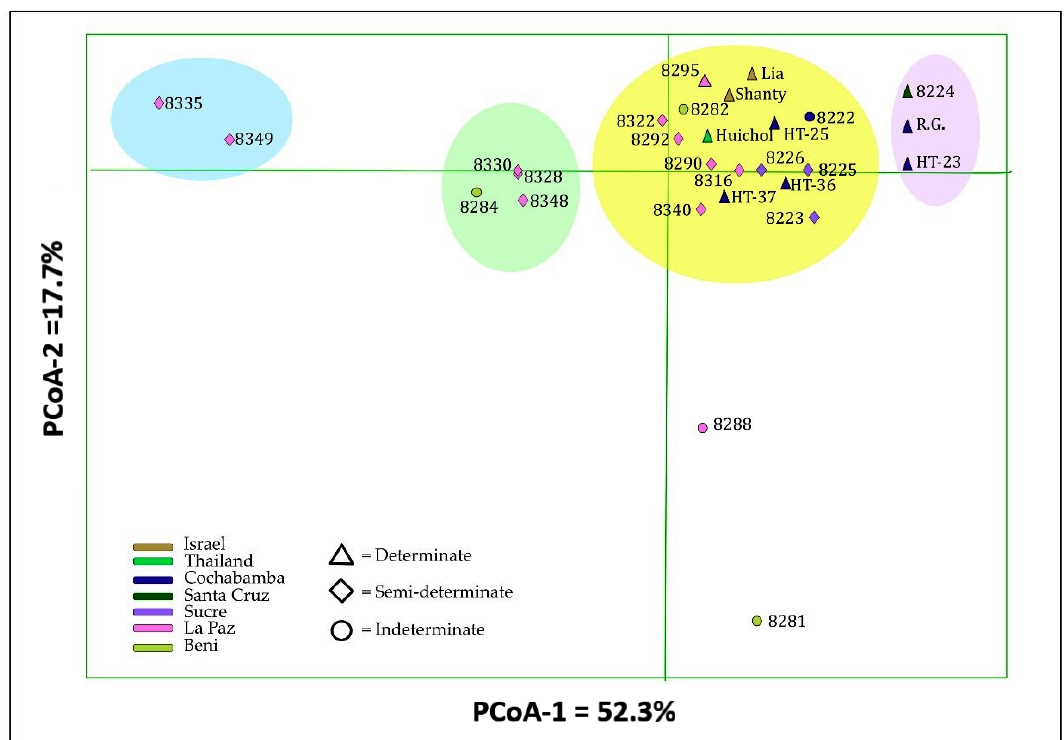
Figure 6. Principal coordinate analysis (PCoA) bi-plot, generated based on Nei’s unbiased genetic distance, demonstrating the relationship between the 28 tomato accessions, with the first two principal coordinates (PCoA1 and PCoA2) explaining 70% of the total variation. Accessions with the same label colour belong to the same region within Bolivia, or to the same country.